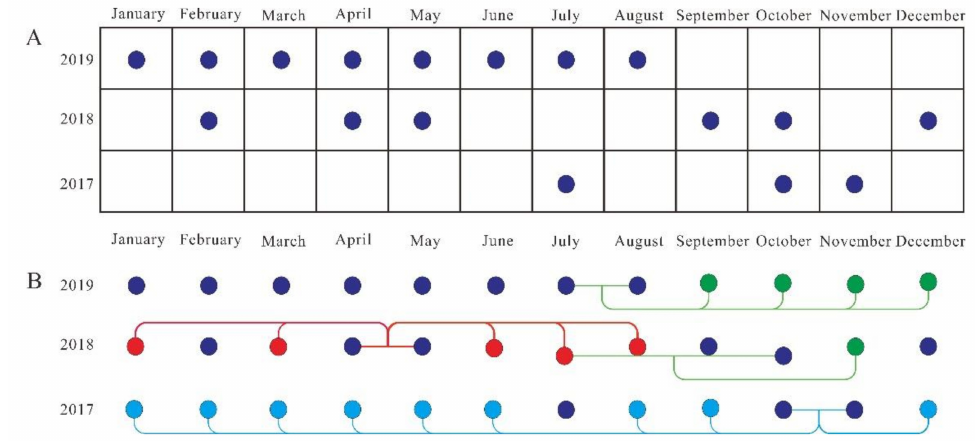
Figure 6. Strategy for generating missing data in third set of experiment: ( A ) available UAV images from 2017 to 2019; ( B ) one generation strategy. Red, green, and cyan-blue curves show lines of first, second, and third level of interpolated